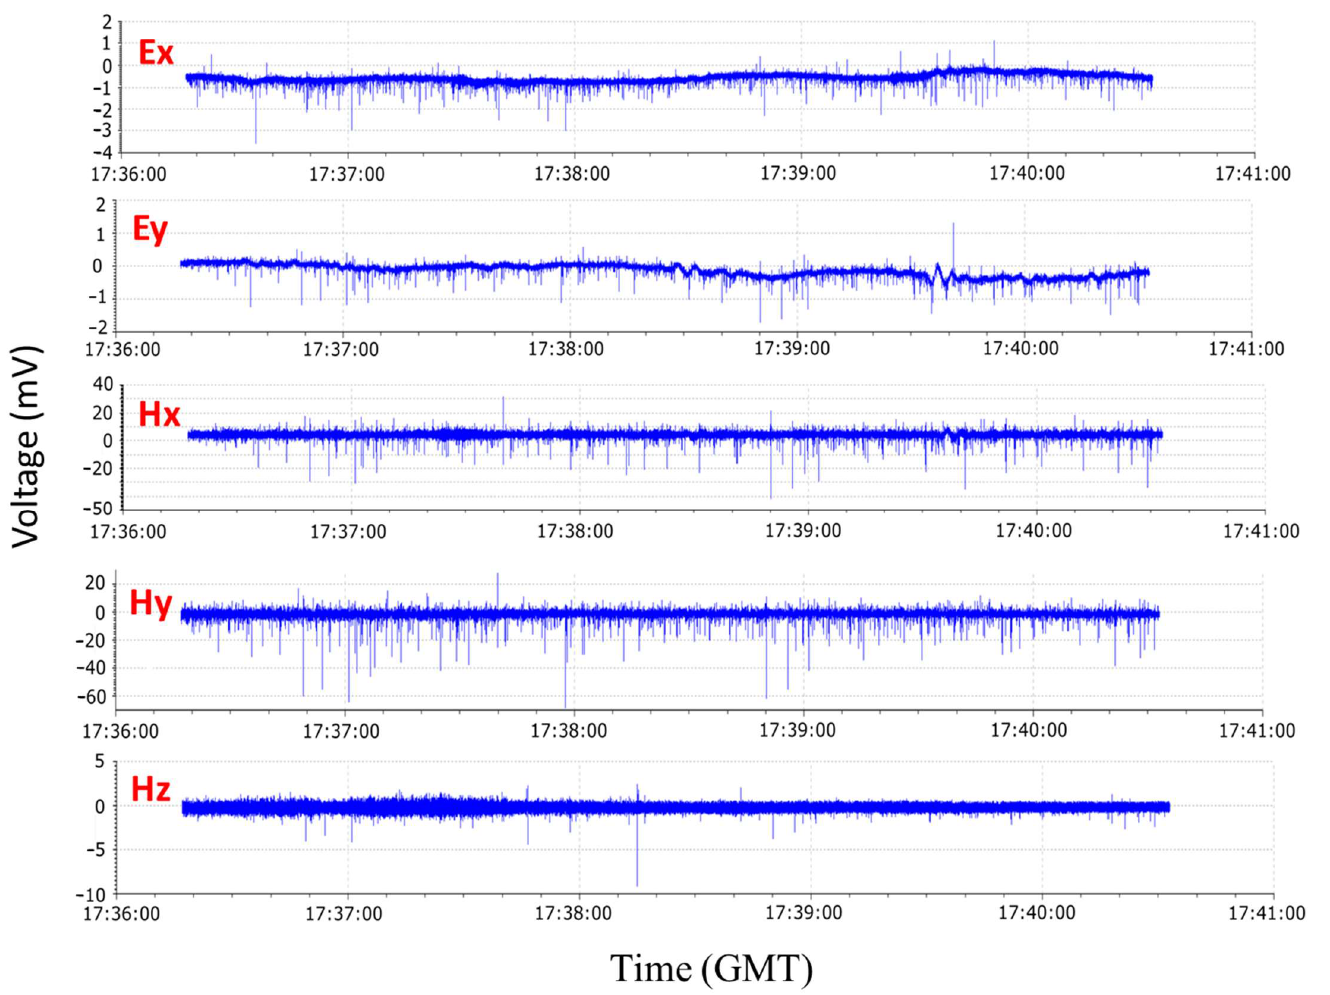
Figure 10. MT raw data time-series: displayed are five channels (Hx, Hy, Hz, Ex, and Ey) from site ST-04 with a 40 Hz sampling rate.